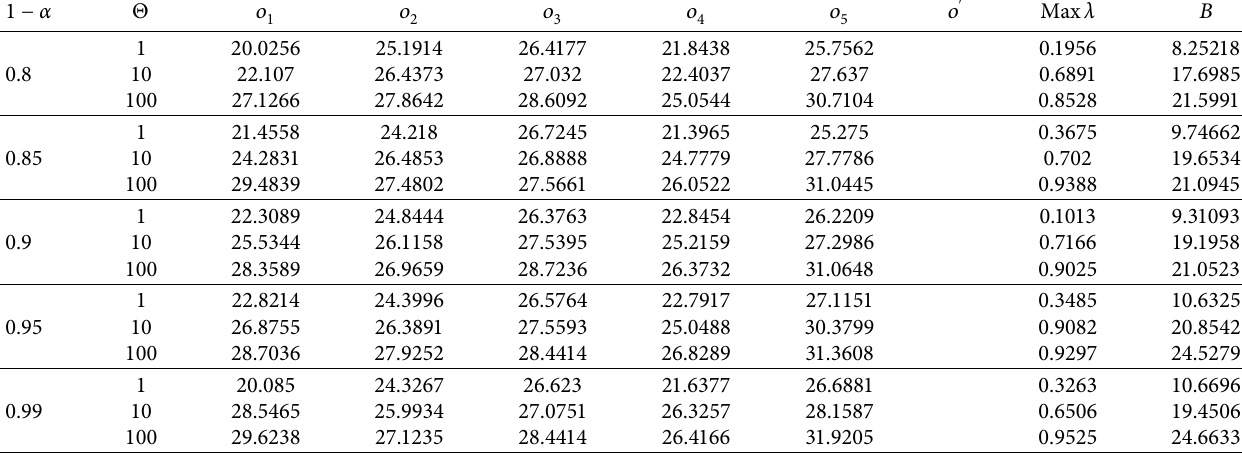
Table 1: Scenario 1: the optimal solution of the model under diferent confdence levels and diferent utility coefcients.